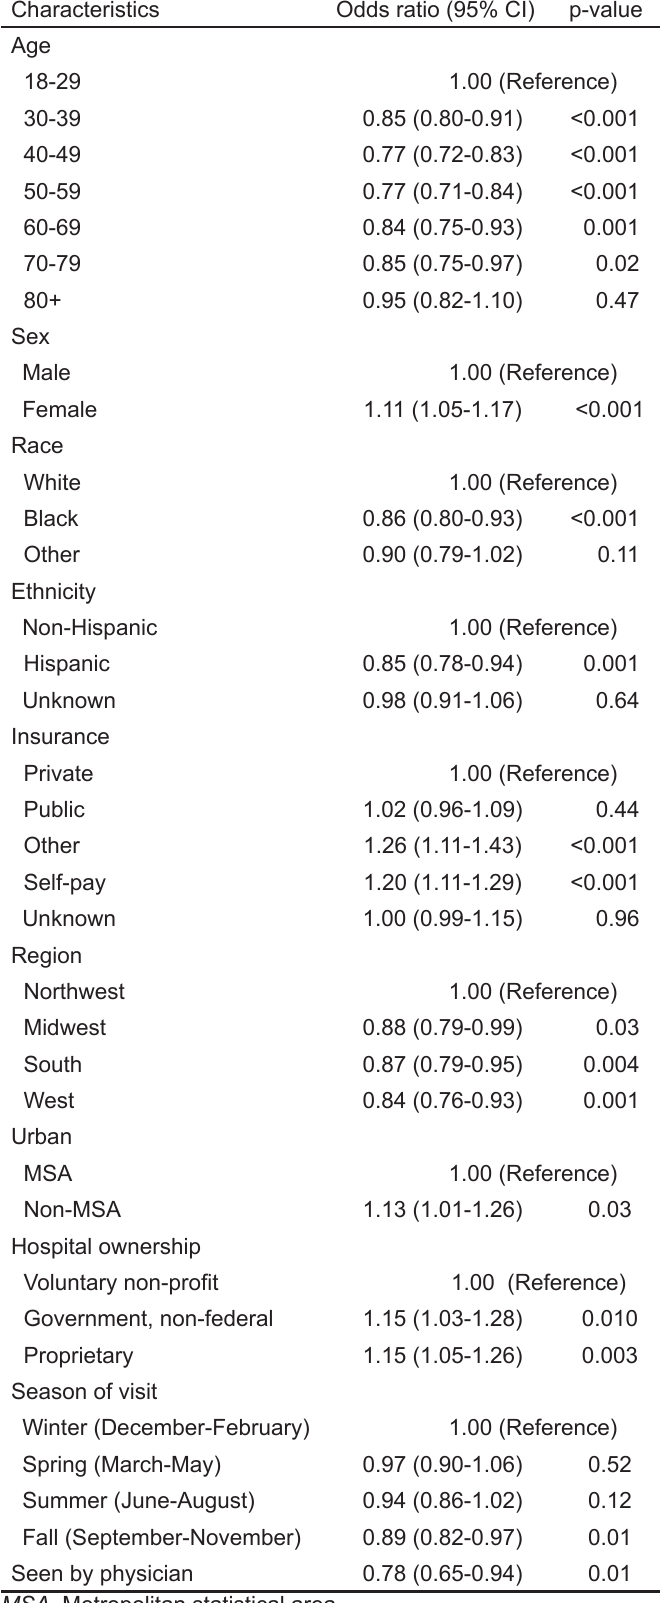
Table 2. Multivariable logistic regression model